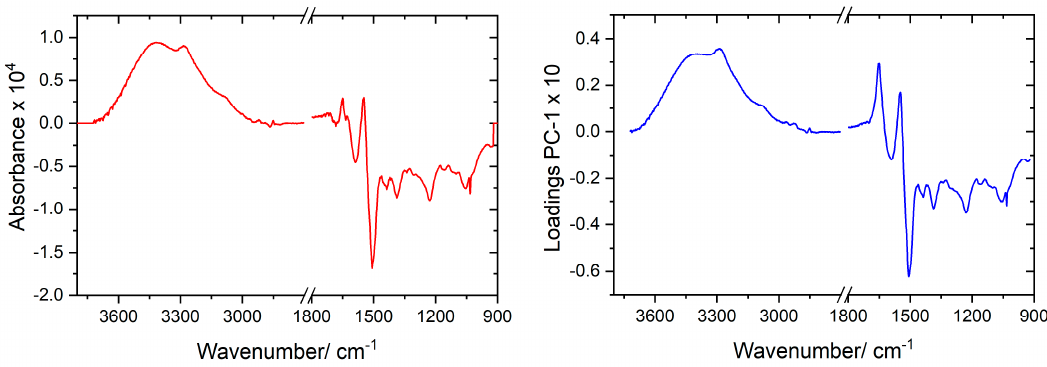
Figure 4. Left panel : Difference IR spectrum (average spectrum of ASD group (A) blood serum minus average spectrum of the control group (C) blood serum). Right panel : PC-1 loadings of PCAModel.